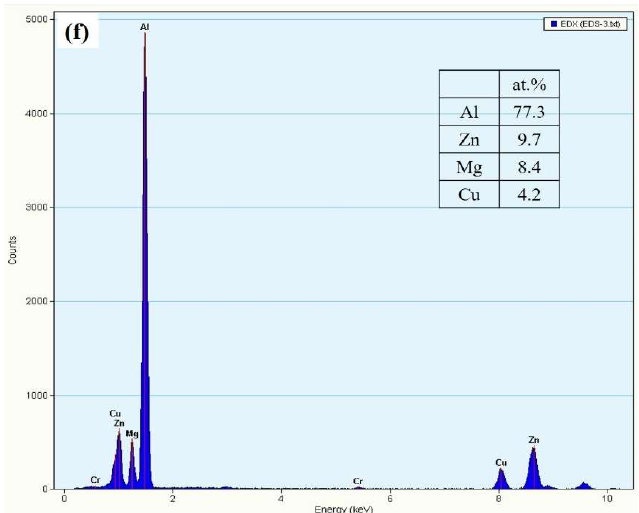
Figure 11. Energy dispersive spectrometer (EDS) for examined specimens, which is shown in Figure 10: ( a ) A point; ( b ) B point ( c ) C point; ( d ) D point; ( e ) E point; and ( f ) F point.